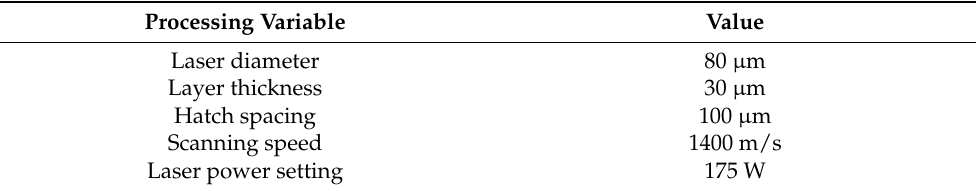
Table 1. EOSINT M280 DMLS processing parameters. Processing